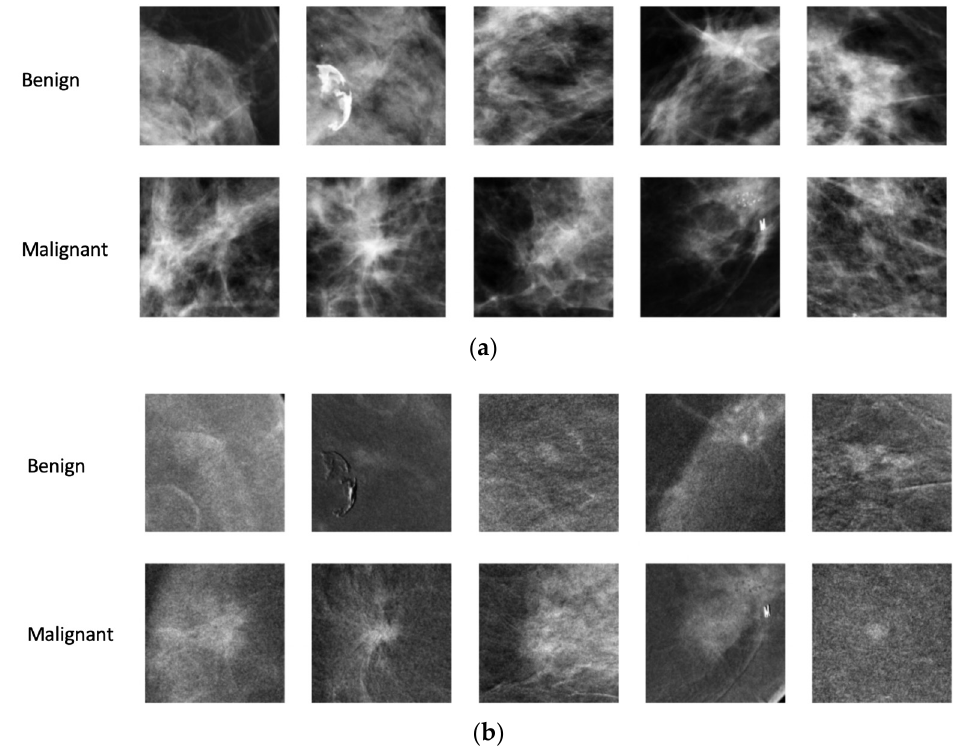
Figure 2. Sample ROIs extracted from ( a ) density and ( b ) contrast